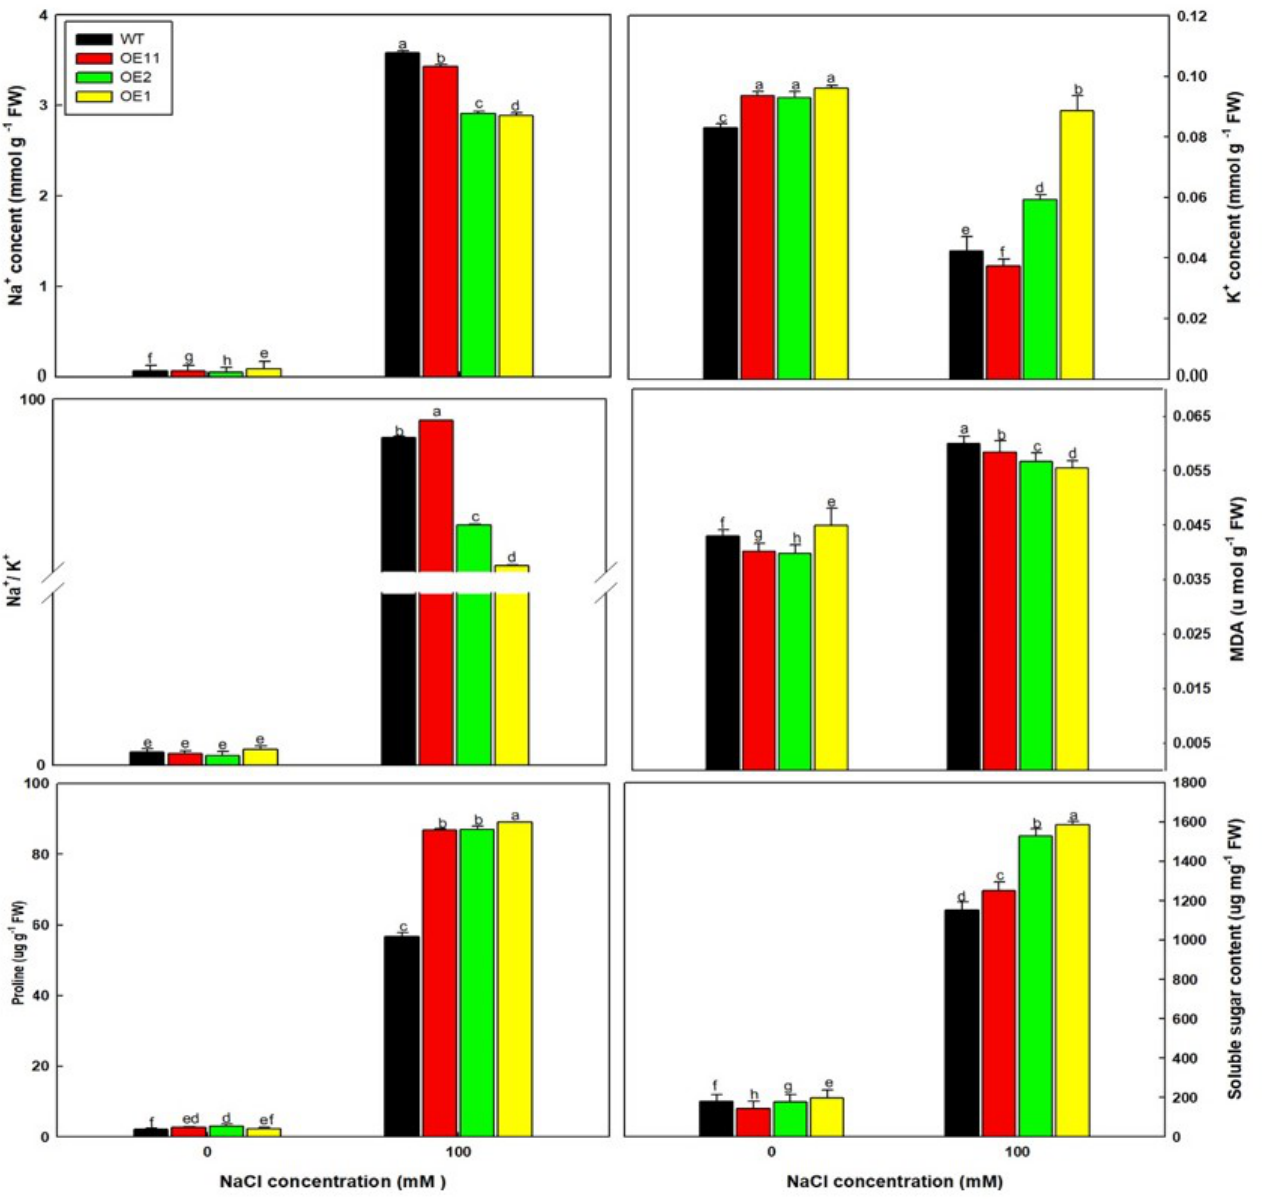
Figure 6. Na + , K + , MDA, proline and soluble sugar contents of Arabidopsis Col-35S:: Lb1G04202 lines under control and 100 mM NaCl growth conditions. Measurements were performed on 20-d-old seedlings, and four replicates were performed per line. Data are the mean ± SD of four plants; different letters indicate significant differences at p = 0.05 according to Duncan’s multiple range